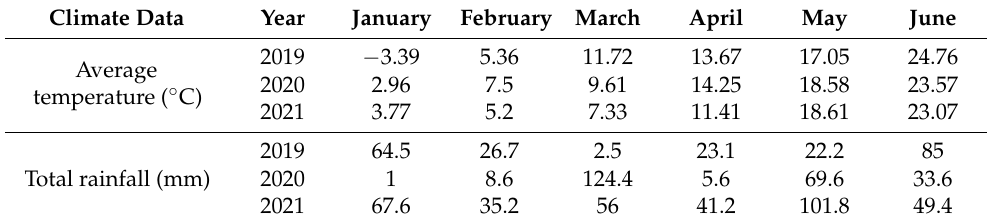
Table 3. Climatic data for the three years of study